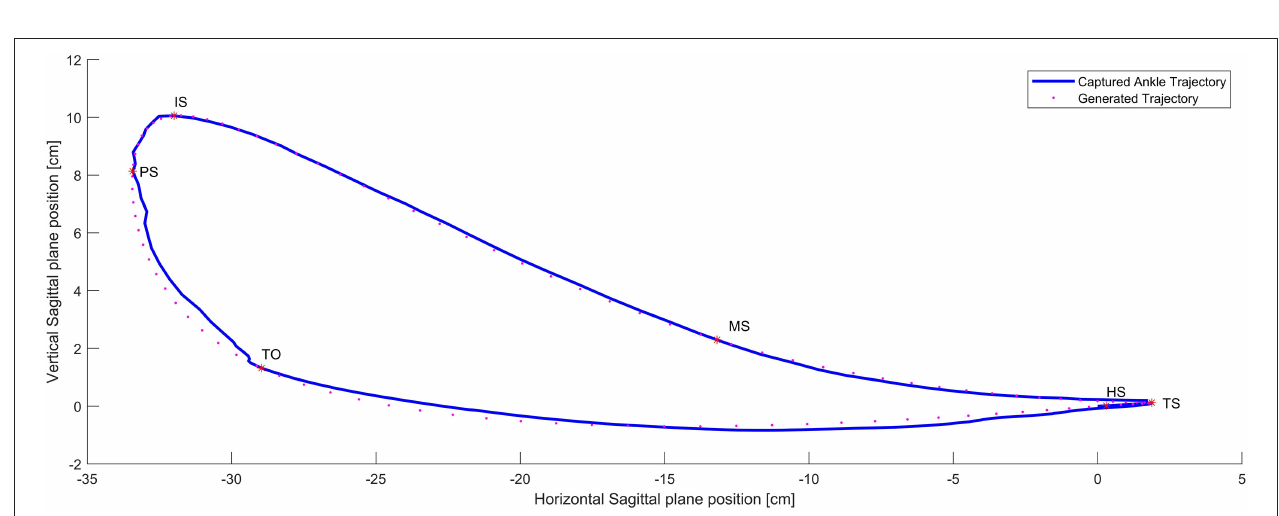
FIGURE 7 | Captured (Full line) Vs Generated Trajectory (Dotted line). Fidelity 97.3 % which is the degree of similarity of both trajectories.